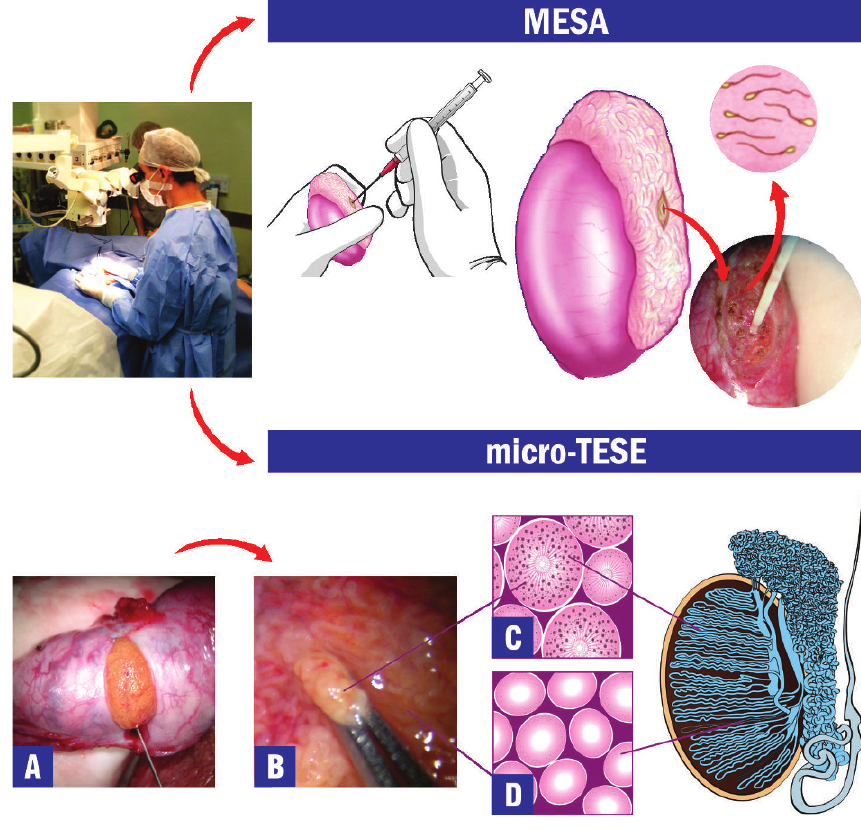
Figure 3 - Microsurgical Sperm Retrieval Techniques. Operating microscope and microsurgical techniques are used throughout the procedures. The top image shows microsurgical epididymal sperm aspiration (MESA). After exposure of the testis and epididymis, a dilated epididymal tubule is dissected and opened. Fluid is aspirated, diluted with sperm medium and sent to the laboratory for examination. The bottom images show microsurgical testicular sperm extraction (micro-TESE). A) After the testicle is exteriorized, a single and large incision is made in an avascular area of the albuginea to expose the seminiferous tubules. B) Dilated tubules are identified and removed with microforceps (intraoperative photograph at 40X magnification). C) Illustration of the histopathology cross-section of a dilated seminiferous tubule with active spermatogenesis. D) Illustration of the histopathology cross-section of a thin tubule with